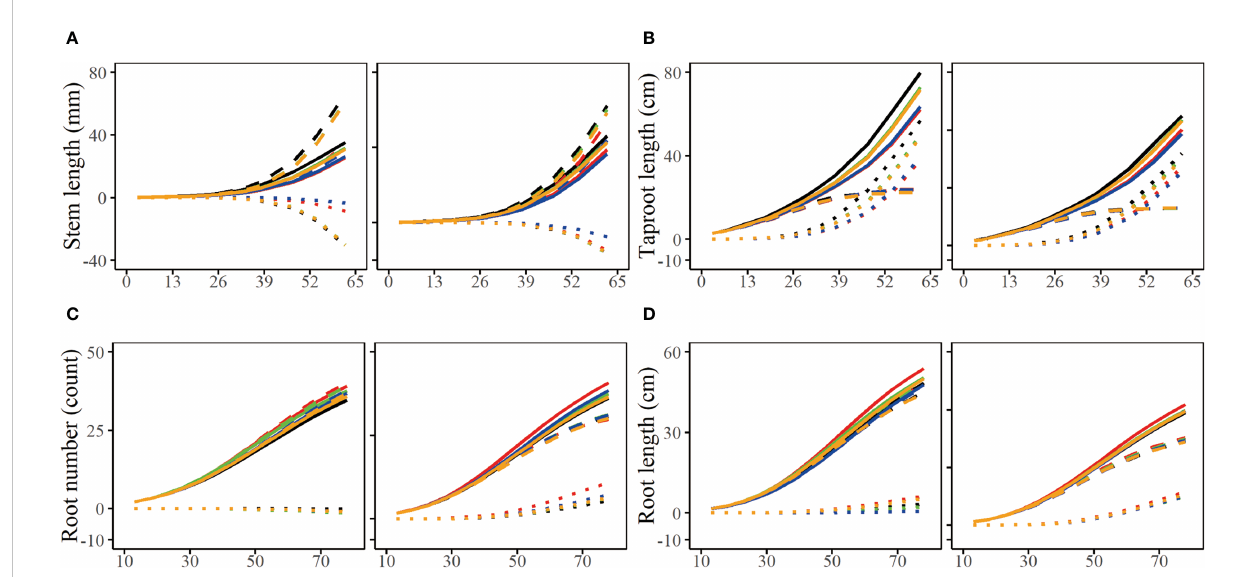
FIGURE 6 Growth curves of stem length (A) , taproot length (B) , root number (C) and root length (D) of two genotypes with a heritability of 0.05 and 0.1. The overall growth (solid line) for each trait is decomposed into independent part (broken line) and interactive part (dotted line). The sample sizes are 100 and 300. Black line represents the real curve, red represents the estimation curve with the sample size of 100 and a heritability of 0.05, blue represents the estimation curve with the sample size of 100 and a heritability of 0.1, the green represents the estimation curve with the sample size of 300 and a heritability of 0.05, the orange represents the estimation curve with the sample size of 300 and a heritability of